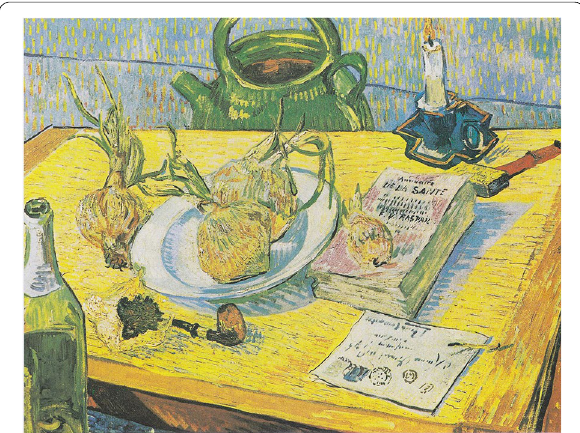
Fig. 3 Still life: Drawing board, pipe, onions and sealing-wax (January 1889), Kröller-Müller Museum, Otterloo, The